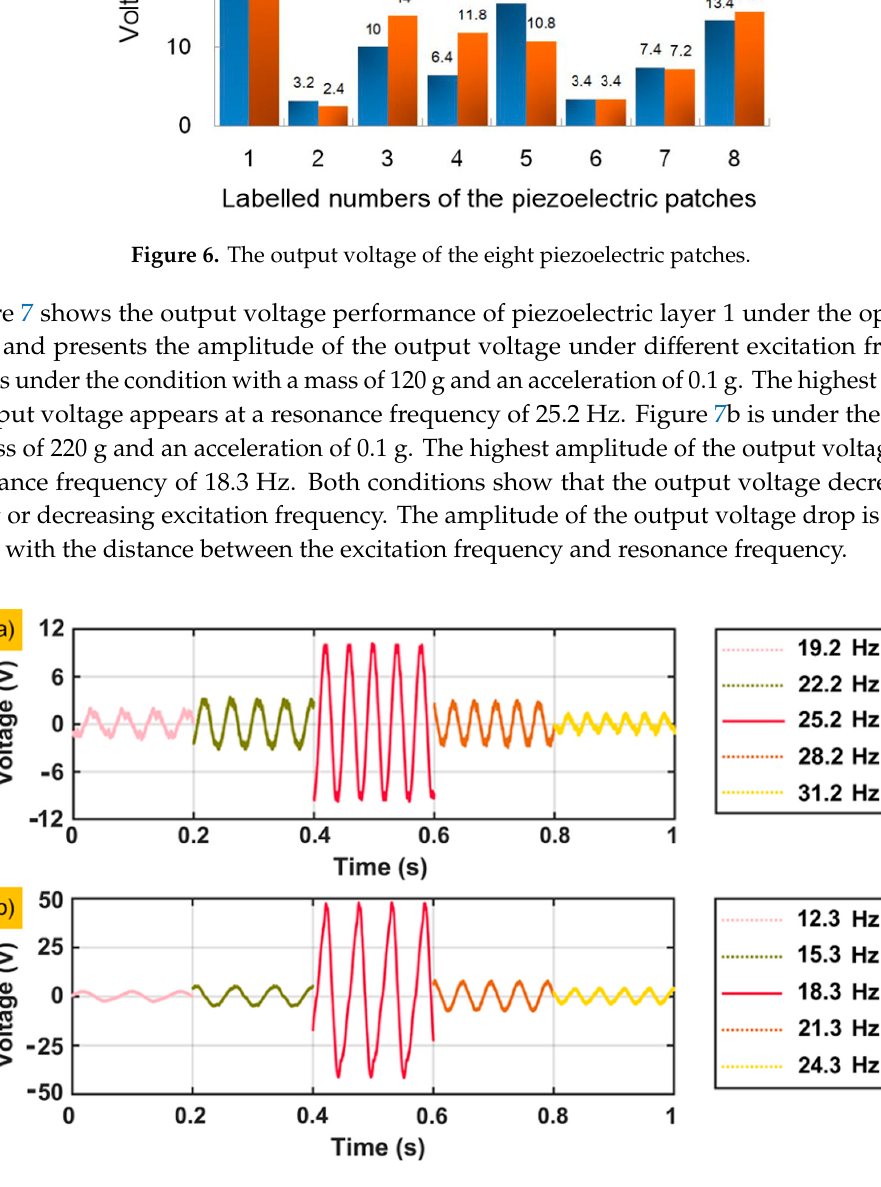
Figure 7. The output voltage performance of the piezoelectric layer labelled number 1 at the exact frequencies: ( a ). Under a mass of 120 g and an acceleration of 0.1 g. ( b ). Under a mass of 220 g and an acceleration of 0.1 g.